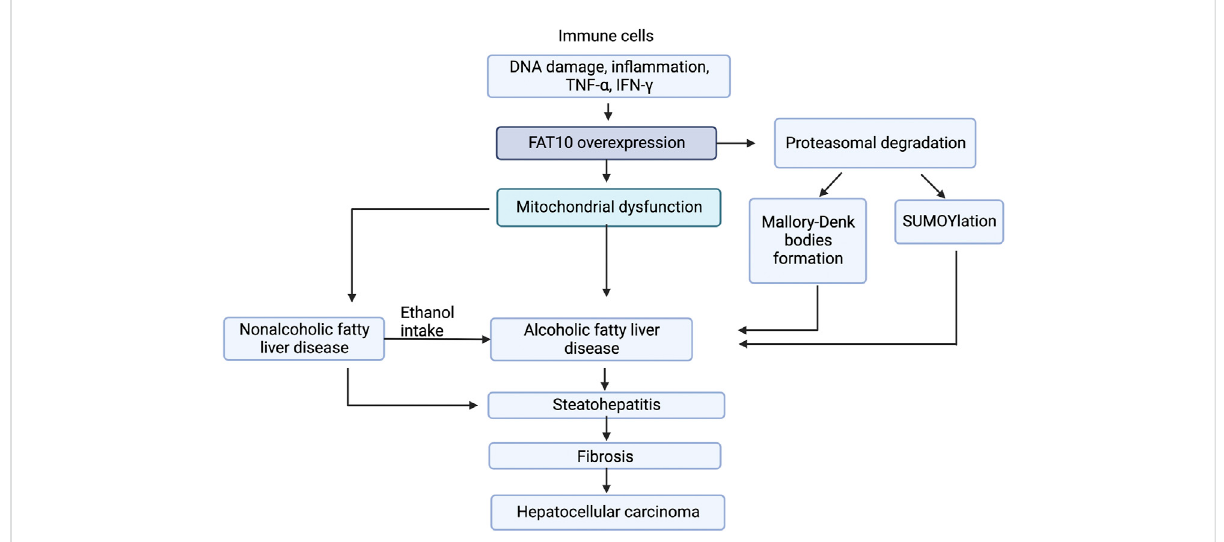
Model for FAT10 effect on liver diseases. The fi gure shows that FAT10 effects fatty liver diseases via altering insulin resistance, mitochondrial function, and in fl ammation responses. Insulin resistance and mitochondrial dysfunction are closely related to in fl ammation suggesting potential signi fi cance of FAT10 in fatty liver disease